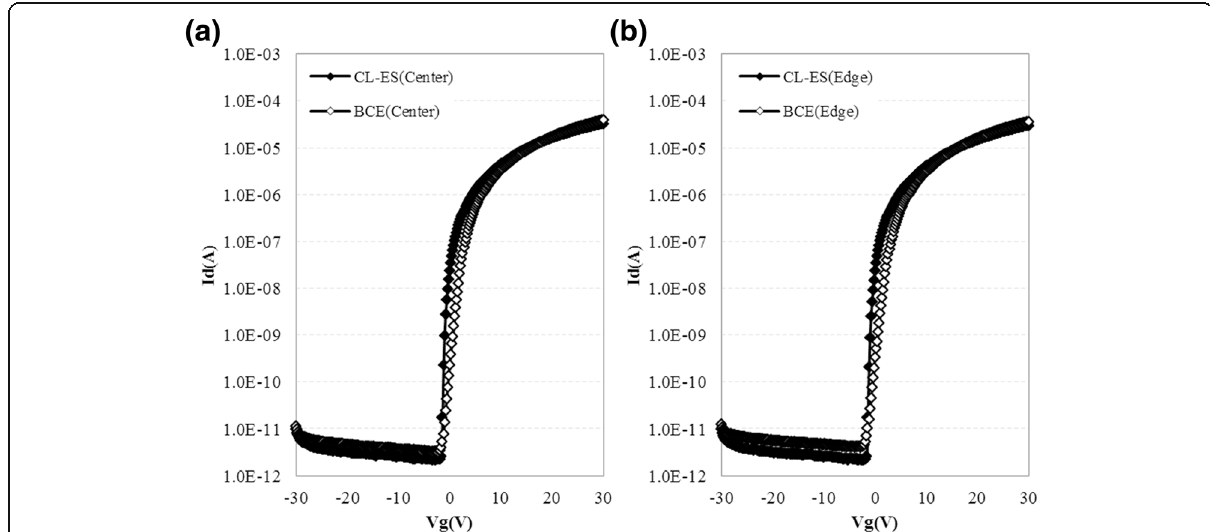
Fig. 4 (Color online) Comparison of I-V characteristic of a-IGZO TFTs with CL-ES and BCE structure on the center ( a ) and edge ( b ) of